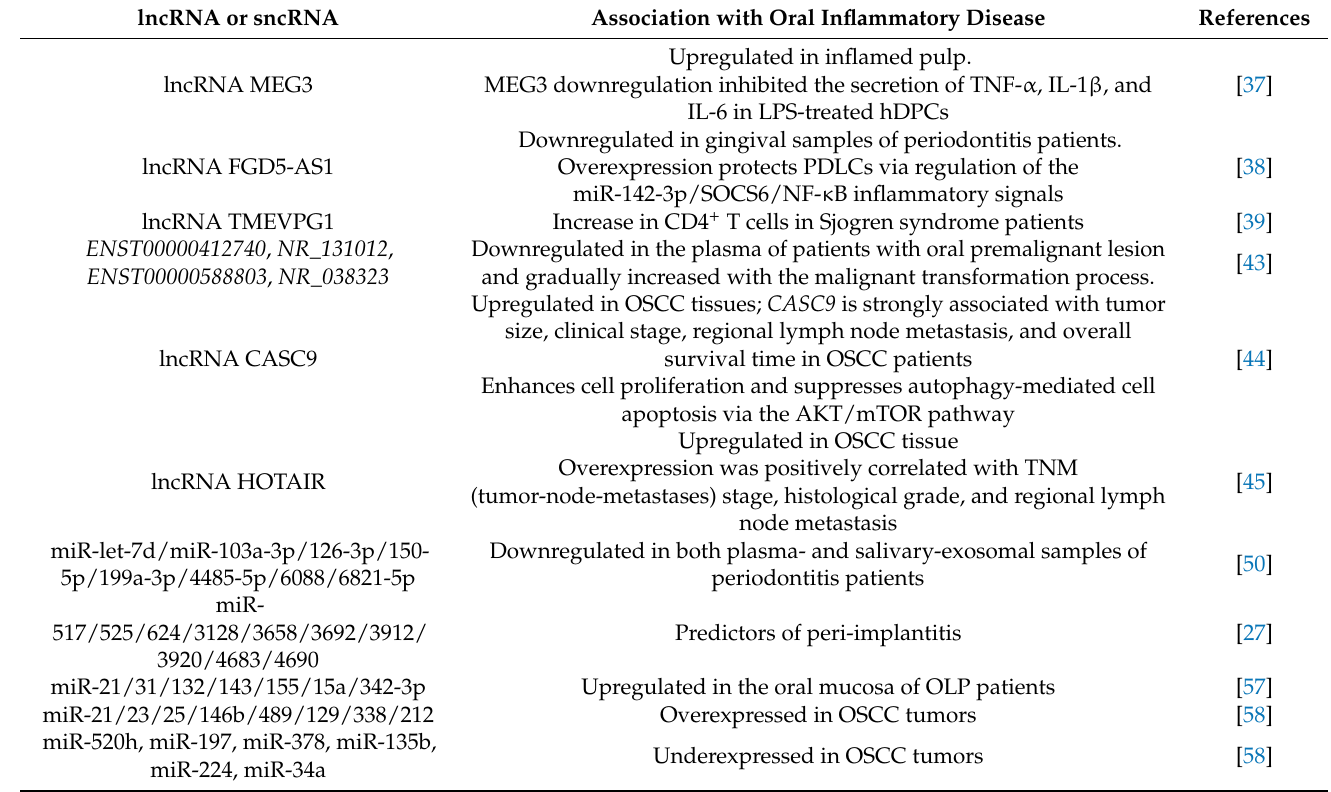
Table 1. LncRNA and sncRNA association with oral inflammatory diseases in clinical